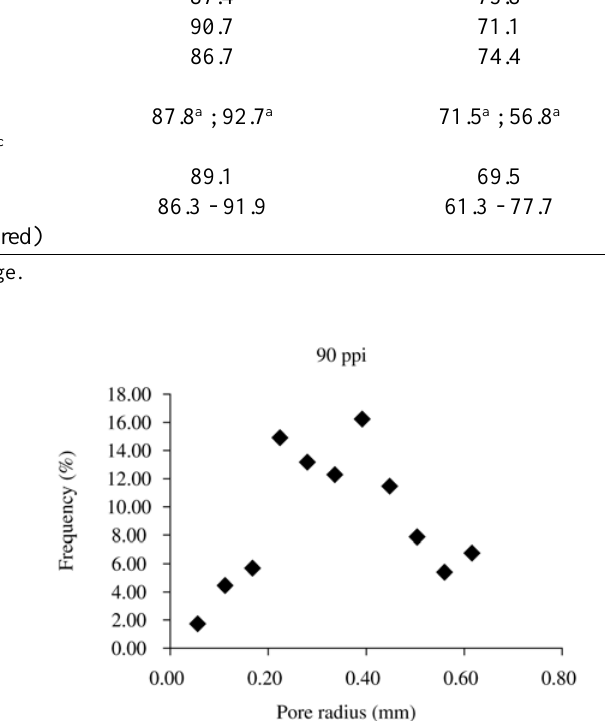
) of the ceramic foam samples. t